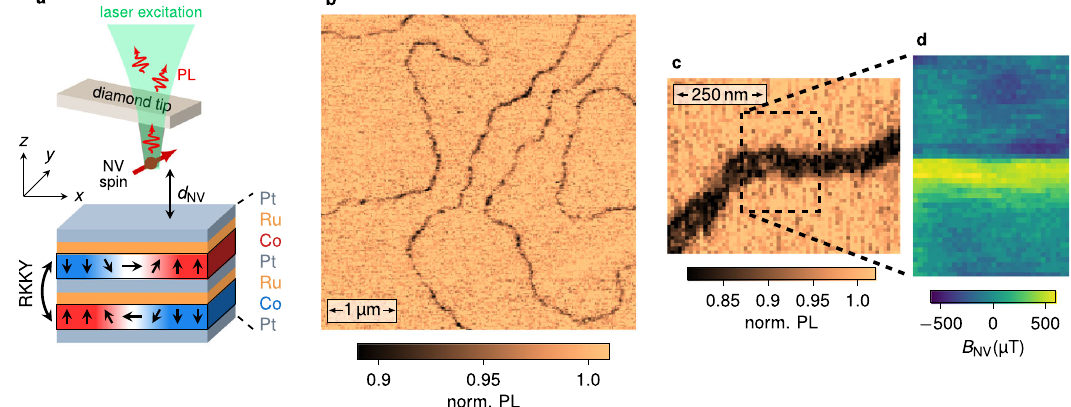
Fig. 2 All-optical imaging of domain walls in a synthetic antiferromagnet. a Simpli fi ed sketch of the scanning-NV magnetometer and the SAF structure. The two magnetic Co layers are antiferromagnetically coupled through the Ru/Pt spacer layer by RKKY exchange interaction. The exact composition of the stack is Ta(10)/Pt(8)/Co( t Co )/Ru(0.75)/Pt(0.6)/Co( t Co )/Ru(0.75)/Pt(3), with the thicknesses in nm. The effective perpendicular magnetic anisotropy of the SAF is controlled by varying the Co thickness t Co . b PL quenching image recorded with the scanning-NV magnetometer above a SAF sample with perpendicular magnetic anisotropy ( t Co = 1.41 nm), showing an overview of the magnetic domain structure. c Closer view of a domain wall. d Static magnetic fi eld distribution recorded above the area marked with the dashed rectangle in c . Only the component of the stray fi eld along the NV quantization ¼ 103 (cid:2) axis, B NV , is measured. This axis is de fi ned by the spherical angles θ NV ¼ 58 (cid:2) ; ϕ NV